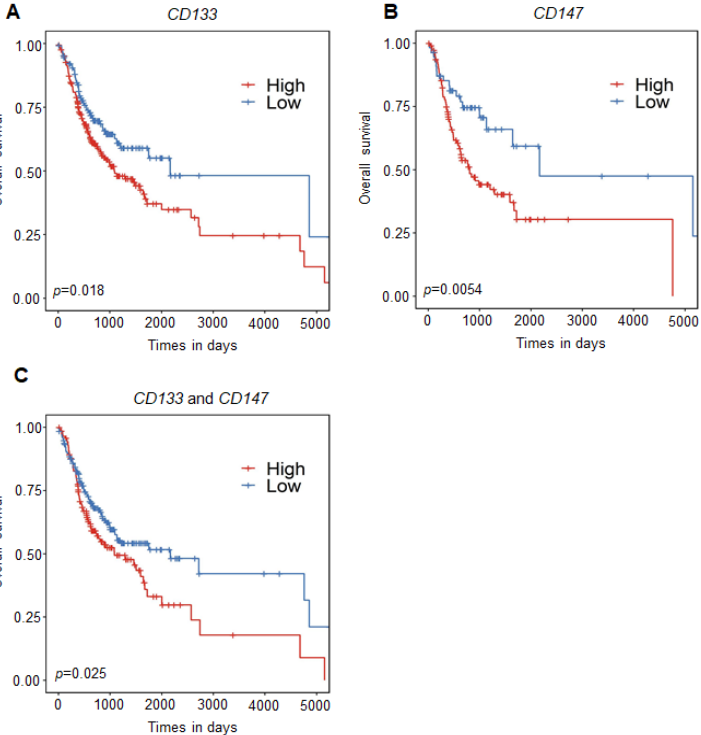
Figure 6. Kaplan-Meier curves showing the effect of CD133 and CD147 DNA methylation on overall survival among patients with OSCC ( n = 338) from the HNSCC TCGA dataset. The overall survival for ( A ) CD133 ( p = 0.018) and ( B ) CD147 ( p = 0.0054), respectively, is shown. A probability of <0.05 (log rank test * p < 0.05) was considered to represent a statistically significant difference. ( C ) Combination of CD133 and CD147 gene methylation ( p = 0.025). The clinical information of patients with OSCC ( n = 338) was divided into two groups according to their methylation status ( β -values) on CD133 (methylation high (red line), n = 209 and methylation low (blue line), n = 129), CD147 (methylation high (red line), n = 113 and methylation low (blue line), n = 55), and a combination of CD133 and CD147 (methylation high (red line), n = 143 and methylation low (blue line), n = 195).